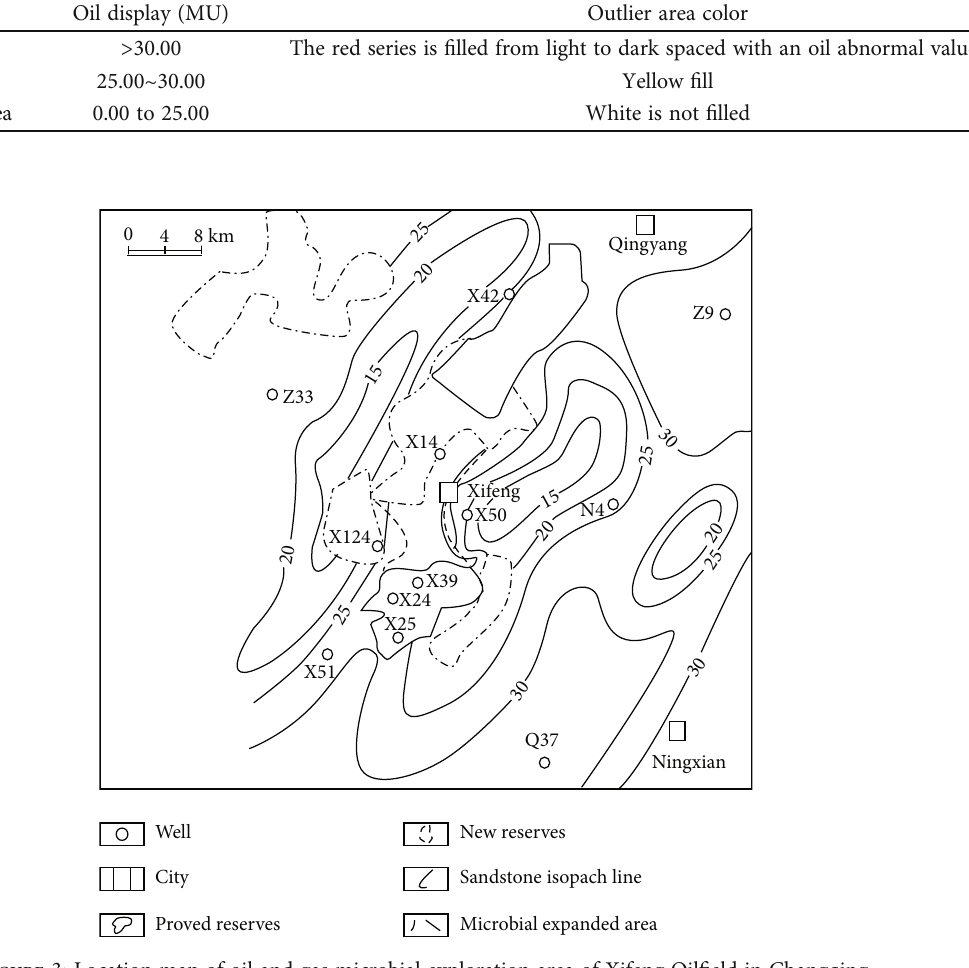
Figure 3: Location map of oil and gas microbial exploration area of Xifeng Oil fi eld in